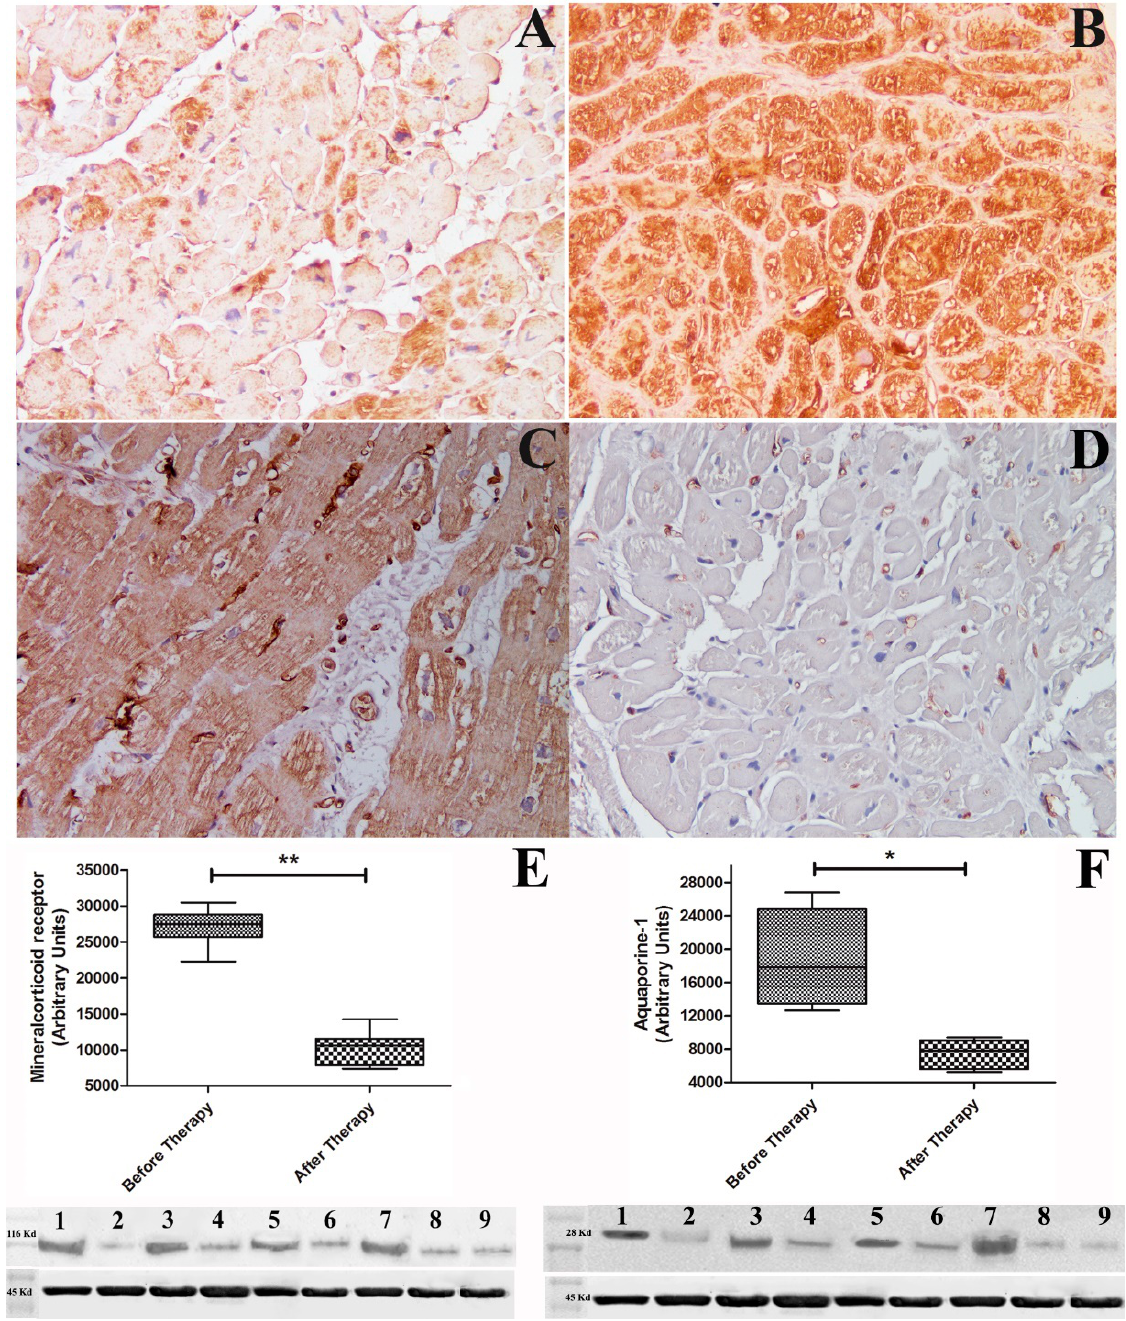
Figure 2. Immunostaining and Western blot quantification of aldosterone and aquaporin 1 receptor under heart failure and after cardiac recovery. Panels ( A , B ): panel ( A ) shows reduced immunostaining for aldosterone receptor that remarkably increases ( B ) with enhancement of cardiac contractility (LVEF from 22% to 55%). Panels ( C , D ): Increased immunostaining for aquaporin 1 in dysfunctioning heart ( C ) that disappears ( D ) after cardiac recovery (Figure magnification 200 × ). Panel ( E ): Western blot of aldosterone receptor (116,000 Da) showing 2.6 increase vs. control during heart failure, which returns to normal after recovery of cardiac function. Panel ( F ): Western blot of myocardial aquaporin 1 (28,000 Da) showing 2.7 fold increase vs. control normalizing after therapy. Alpha sarcomeric actin (45,000 Da) was used as loading control. Lanes 1, 3, 5, 7 = Western blot of patients during heart failure. Lanes 2, 4, 6, 8 = Western blot of patient after recovery. Lane 9 = control. * indicates p value < 0.05; ** indicates p value < 0.001.